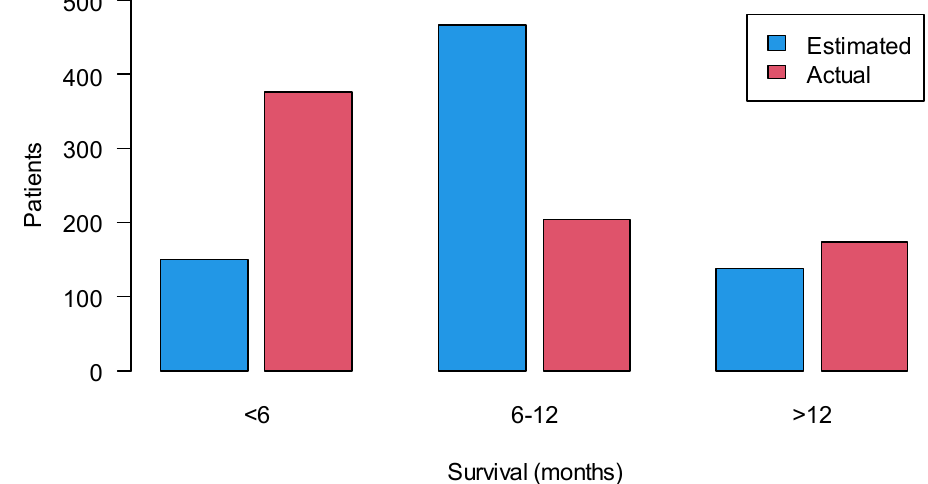
Figure 3. Comparison between actual and estimated survival.